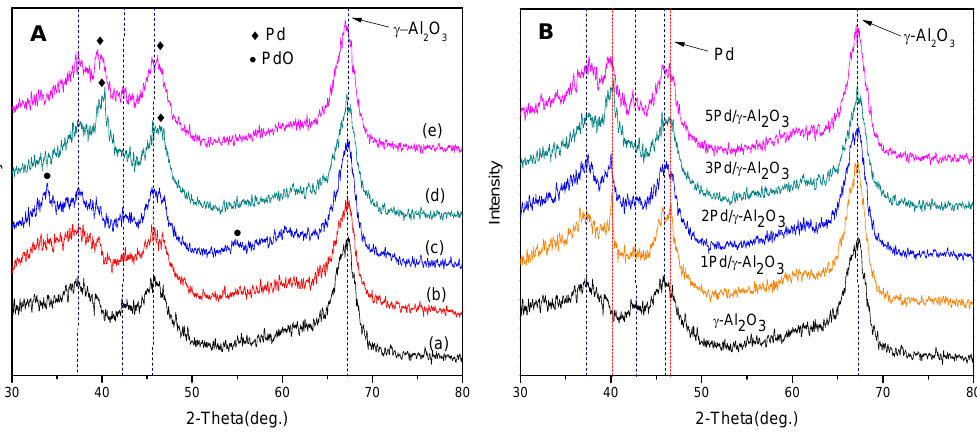
Figure 1. XRD patterns of the samples. ( A ): ( a ) γ‐ Al 2 O 3 : γ‐ Al 2 O 3 support; ( b ) UC ‐ 3 wt. % Pd/ γ‐ Al 2 O 3 : γ‐ Al 2 O 3 support was only impregnated with aqueous liquid of PdCl 2 ; ( c ) UR ‐ 3 wt. % Pd/ γ‐ Al 2 O 3 : UC ‐ Pd/ γ‐ Al 2 O 3 catalyst was calcined at 500 °C for 4 h; ( d ) 3 wt. % Pd/ γ‐ Al 2 O 3 : UR ‐ Pd/ γ‐ Al 2 O 3 catalyst was reduced with H 2 at 450 °C for 2 h; ( e ) used 3 wt. % Pd/ γ‐ Al 2 O 3 : Pd/ γ‐ Al 2 O 3 catalyst recycled after reaction; ( B ): patterns of catalysts with different Pd loading on γ‐ Al 2 O 3 .